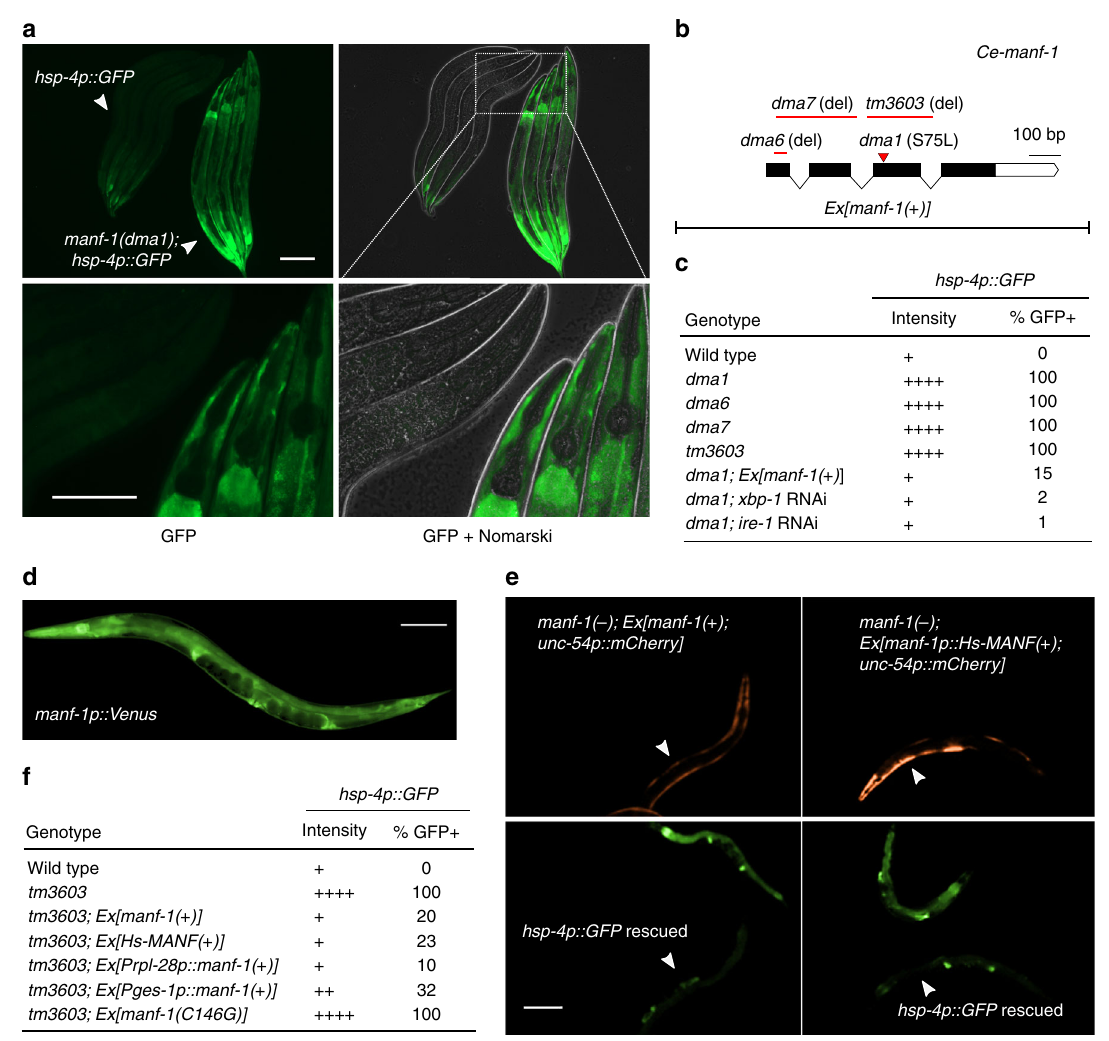
Fig. 1 A genetic screen identi fi es C. elegans manf-1 in regulating hsp-4p::GFP . a Exemplar GFP fl uorescence and Nomarski images showing constitutive activation of hsp-4p::GFP in the dma1 mutant isolated from mutagenesis screens. Wild type and mutant L4-stage animals (indicated by arrows) are aligned in the same fi eld to compare GFP intensity at low (above) or high (bottom) magni fi cation. Scale bars, 100 µ M. b Schematic of manf-1 gene structure with various manf-1 alleles and extrachromosomal arrays (Ex) indicated. c Summary table for the hsp-4p::GFP phenotype of the wild type compared with various mutants, with indicated levels of GFP intensity in the intestine, the major site of hsp-4p::GFP expression, and penetrance ( N ≥ 100 for each genotype). d Integrated manf-1p::Venus transcriptional reporter indicating the widespread expression of manf-1 . e Exemplar GFP fl uorescence images showing the rescue of the hsp-4p::GFP phenotype in the manf-1 null tm3603 mutant by C. elegans manf-1( + ) and human MANF driven by the manf-1 promoter. Transgenic rescuing arrays are marked by unc-54p::mCherry expressed in body wall muscles. f Summary table showing the rescuing effect of various transgenes on hsp- 4p::GFP of the manf-1(tm3603) mutant with indicated GFP intensity levels and penetrance ( N ≥ 100 for each